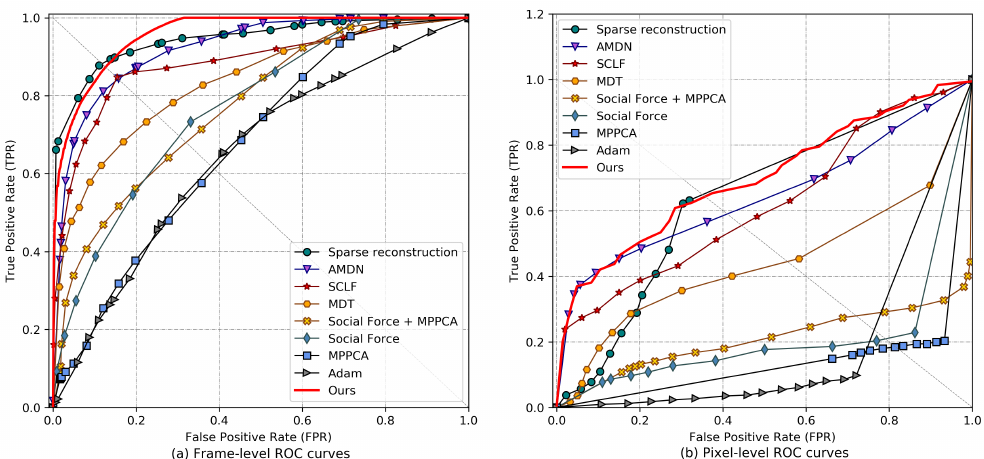
Figure 4. Receiver operating characteristic (ROC) comparisons of different methods on Ped1 dataset.